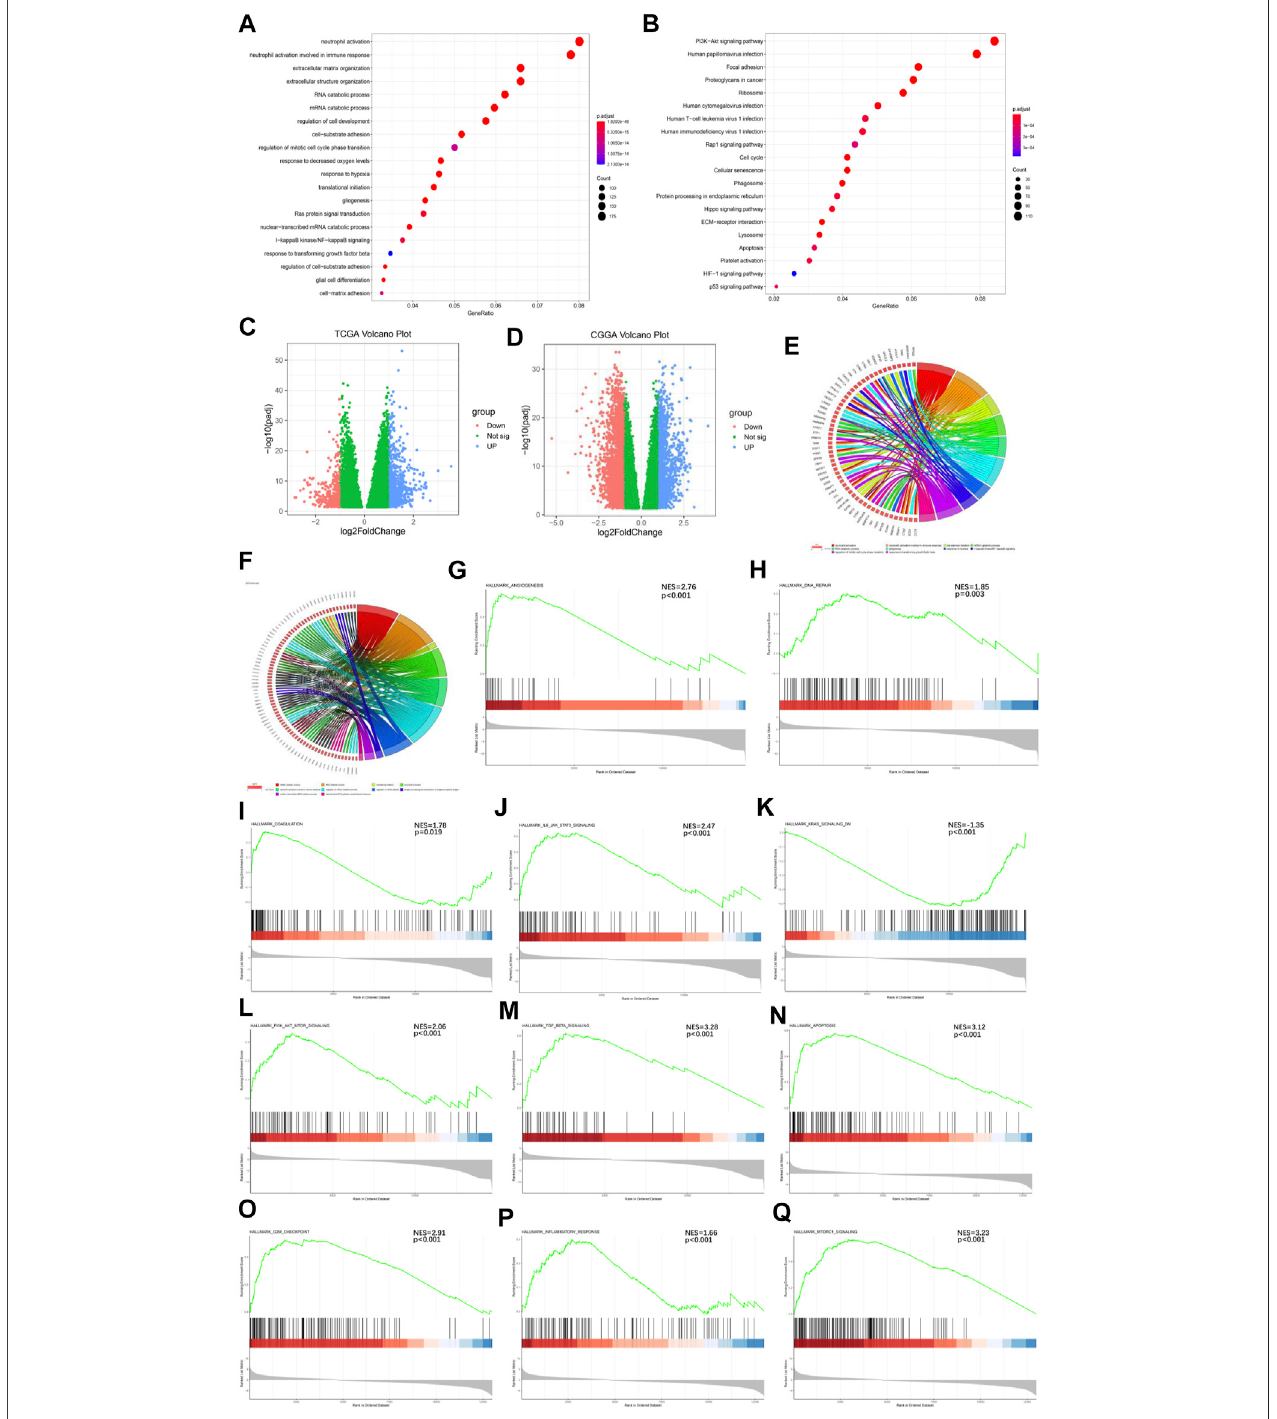
FIGURE 3 | Interaction among functional annotation of GBM and 21 m6A RNA methylation regulators in CL1/2 subgroups. (A) Functional annotation for m6A- related genes using GO enrichment analysis in TCGA-GBM cohort. (B) Functional annotation for m6A-related genes using KEGG enrichment analysis in TCGA-GBM cohort. (C) Interactionamong21m6ARNAmethylationregulatorsandfunctionalannotationofGBMinCL1/2subgroupsinTCGAcohort. (D) Interactionamong21m6A RNA methylation regulators and functional annotation of GBM in CL1/2 subgroups in CGGA cohort. The red dots represent downregulated DEGs, the green dots representnon-regulatedDEGs,andthebluedotsrepresentupregulatedDEGs. (E) FunctionalannotationoftheupregulatedDEGsintheCL2subgroupofGOanalysisin TCGA cohort. (F) Functional annotation of the upregulated DEGs in the CL2 subgroup of GO analysis in CGGA cohort. (G – Q) GSEA revealed that genes with higher